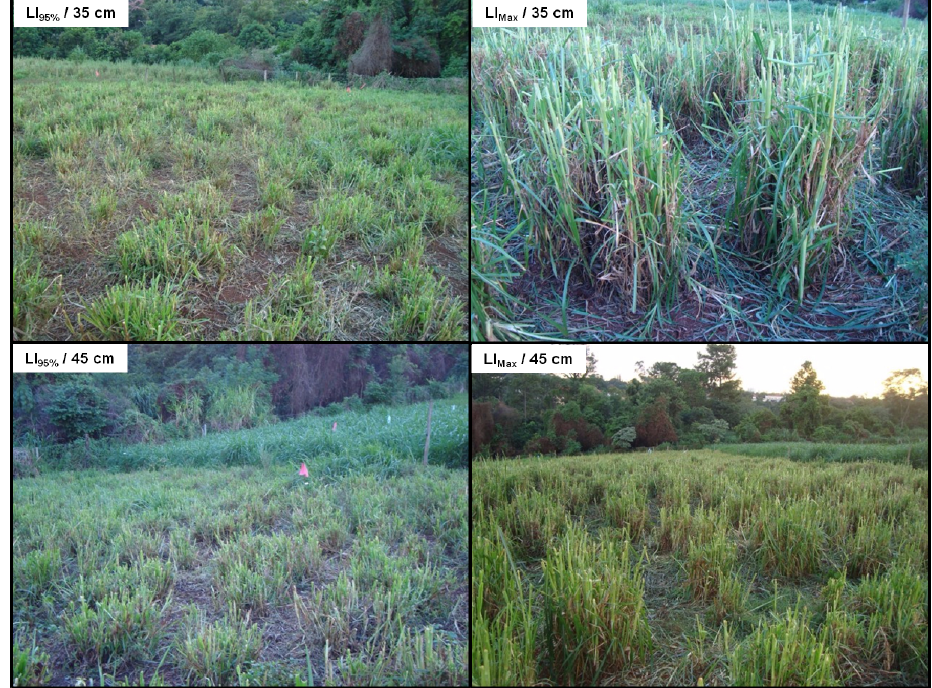
Figure 2. Tussock size and distribution in Pennisetum purpureum cv. Napier paddocks subjected to strategies of rotational stocking management characterized by pre-grazing targets of 95% and maximum canopy light interception during regrowth (LI 95% and LI Max ) and post-grazing targets of 35 and 45